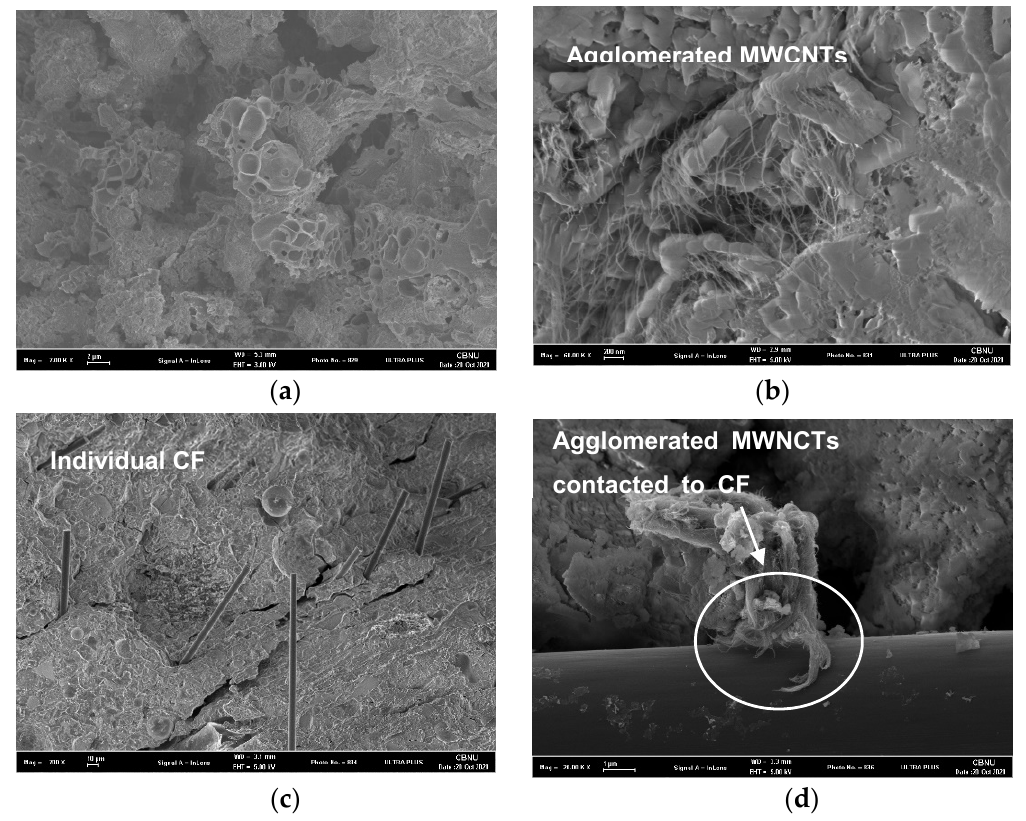
Figure 5. SEM micrograph images of ( a ) F0N0, ( b ) F0N10, ( c ) F10N0, and ( d ) F10N10 specimens.